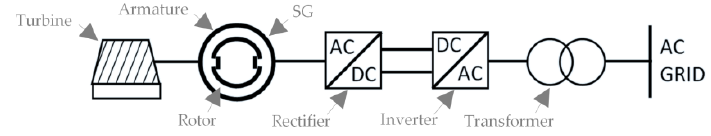
Figure 1. Use of a back-to-back frequency converter.